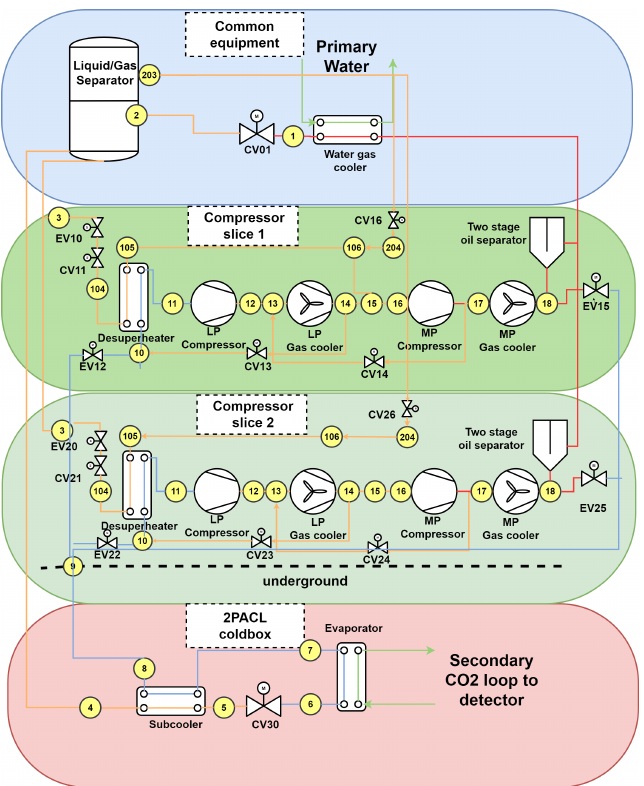
Figure 4. Simplified P&ID diagram of System A with common equipment, compressor slices and cold box. Reference to the state points of pressure-enthalpy diagram of Figure